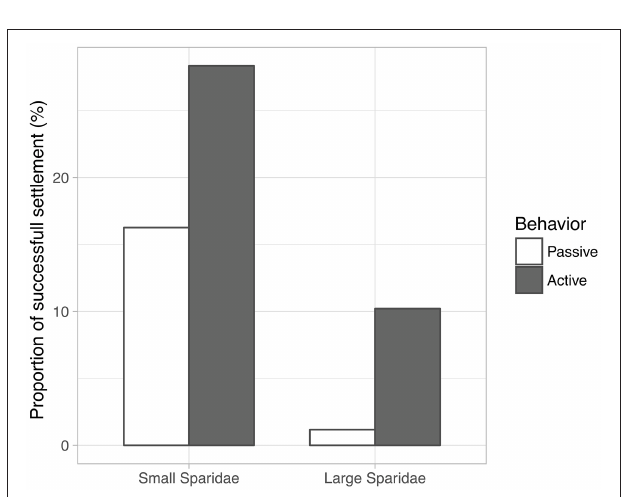
FIGURE 3 | Proportion of virtual larvae that successfully reached a coastal habitat during their competency